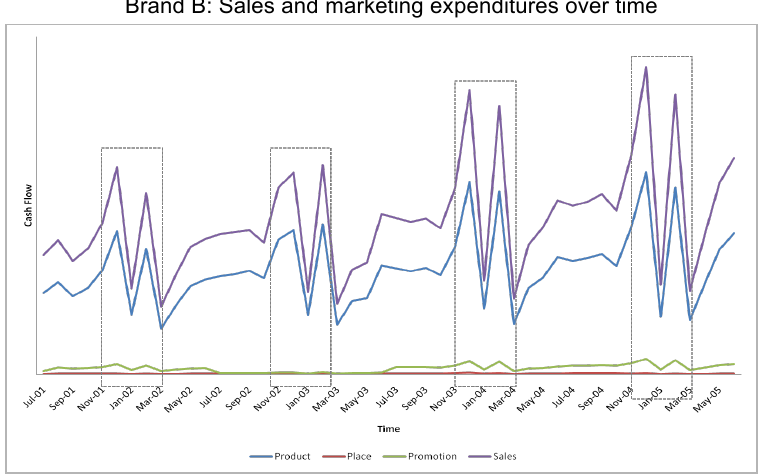
Brand B: Sales and marketing expenditures over